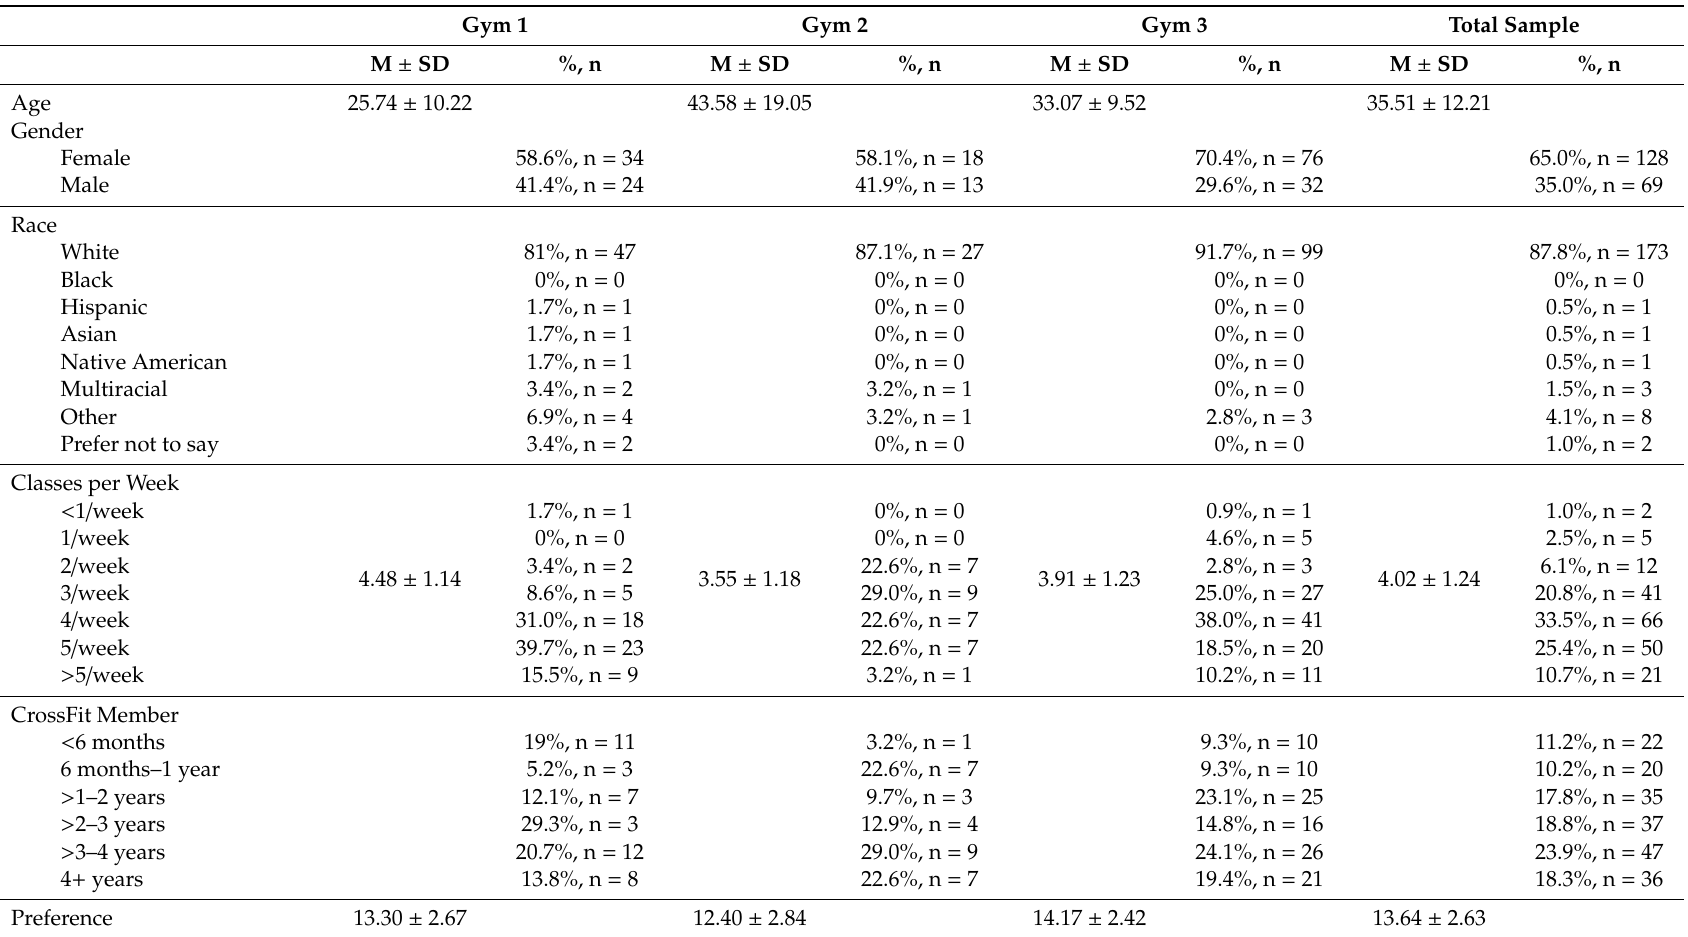
Table 1. Sample characteristics of members from three CrossFit